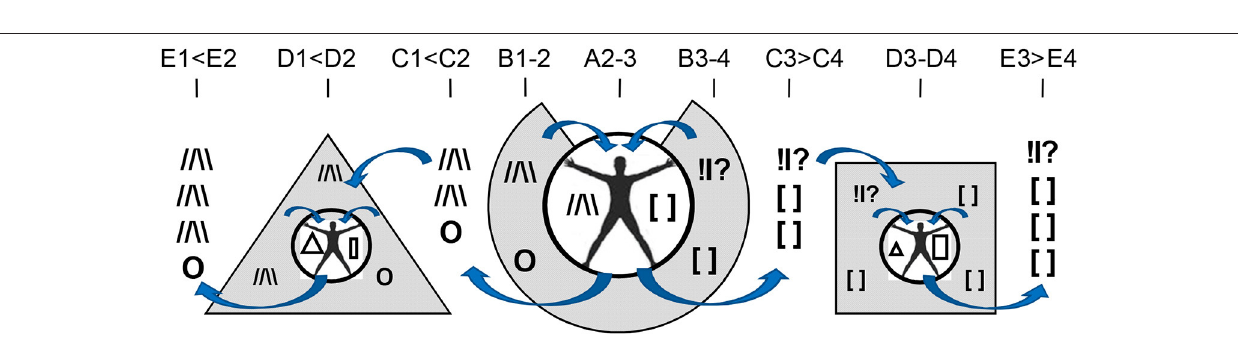
FIGURE 1 | The concept of interactive Extended Phenotype. (1) : (A) in order to survive, humans receive resources from (B) the infrastructure provided by a society to respond to their vital needs. This makes the environmental resource-infrastructure an extended part of an individual’s body. In return, the infrastructure uses individuals for producing actions, services and objects supporting this infrastructure (C). (2) : Excessive abilities of an individual are trimmed by societal infrastructure or force the infrastructure to expand its expectations (A > B). In cases of disabilities (A < B), additional environmental resources are required, often leading to the development of environmental infrastructure.